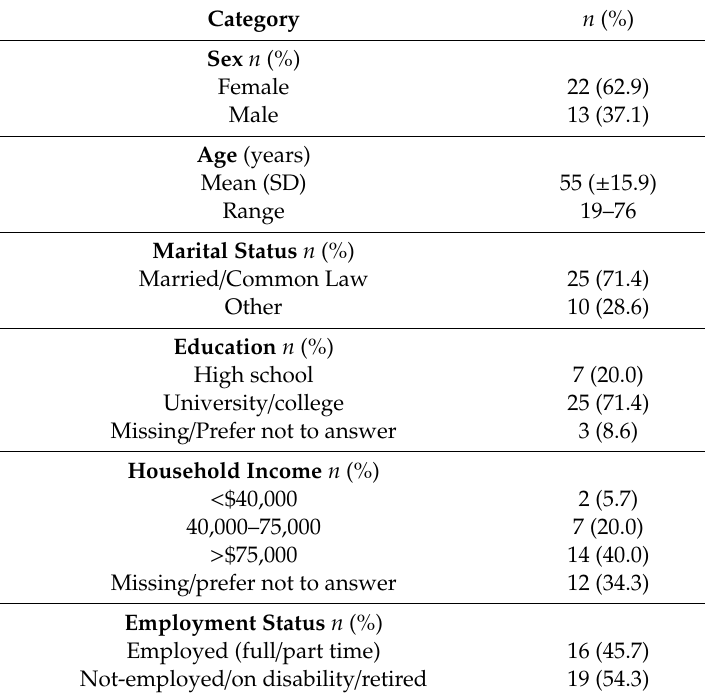
Table 2. Participant